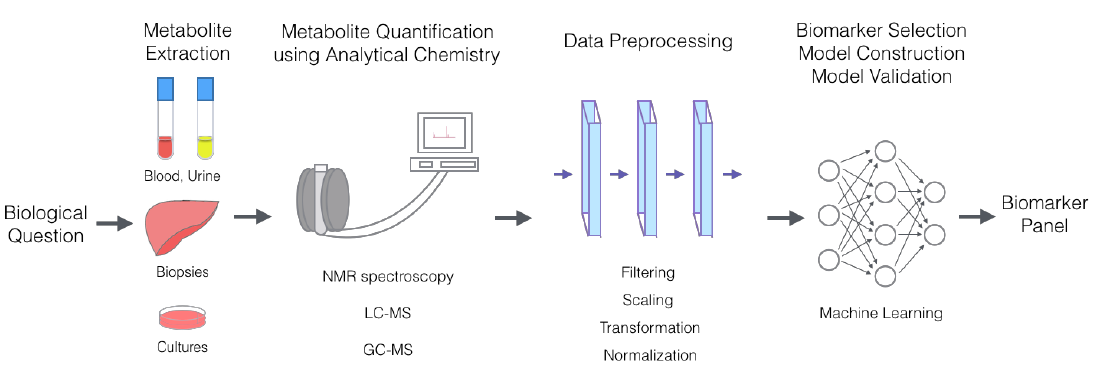
Figure 1. General workflow of the metabolic marker discovery process. Metabolite extraction often can be performed from cells, tissues, organs and fluids, including blood and urine. Metabolite quantification is performed using analytical chemistry techniques, such as LC-MS, GC-MS and NMR, which provide concentration values for each metabolite in solution. Biomarker selection and model construction are conducted using various machine learning